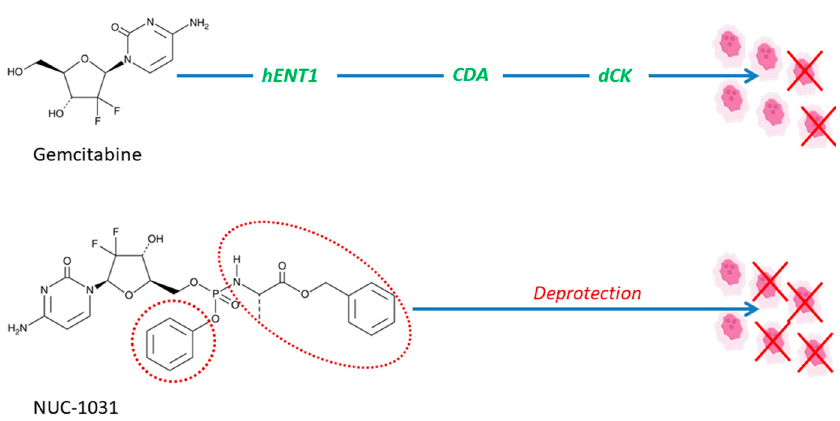
Figure 3. NUC-1031 overcomes the main resistance mechanisms associated with gemcitabine, in particular, transport via human equilibrative nucleoside transporters (hENT1), breakdown via cytidine deaminase (CDA), and activation via deoxycytidine kinase (dCK). NUC-1031 is designed to create and retain higher drug levels concentrations of metabolite inside the tumor in comparison to gemcitabine. The promoieties are shown with a dashed red line.